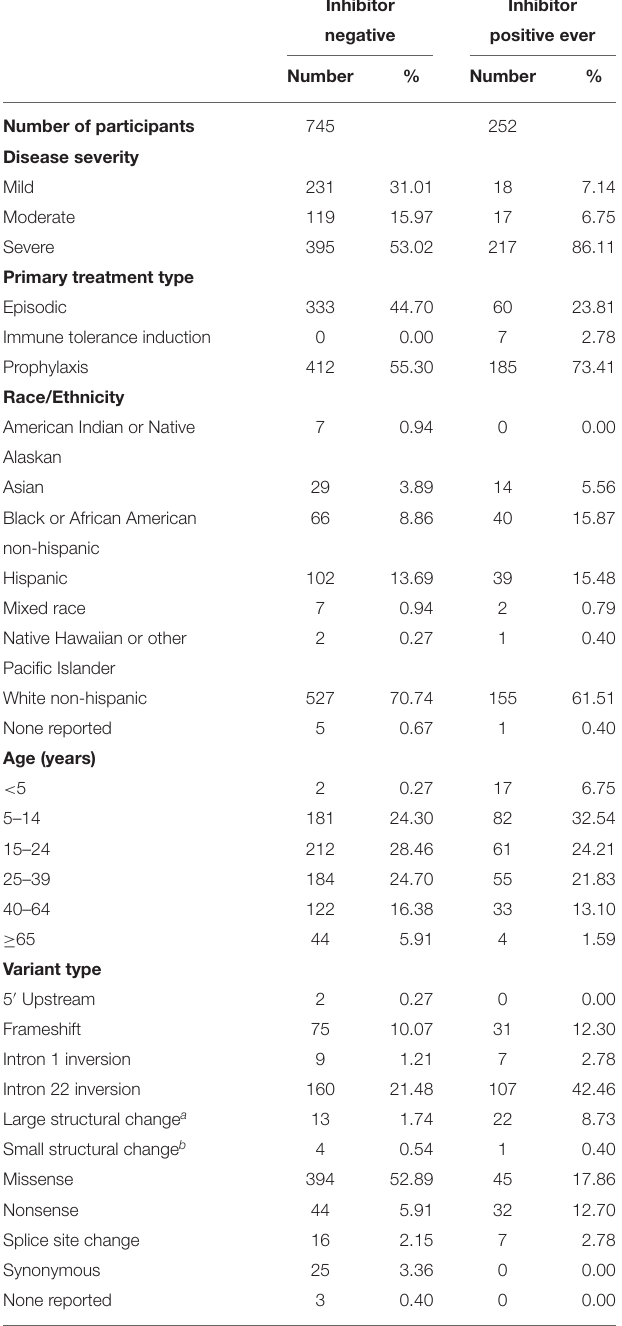
TABLE 3 | Participant characteristics, HLA typed